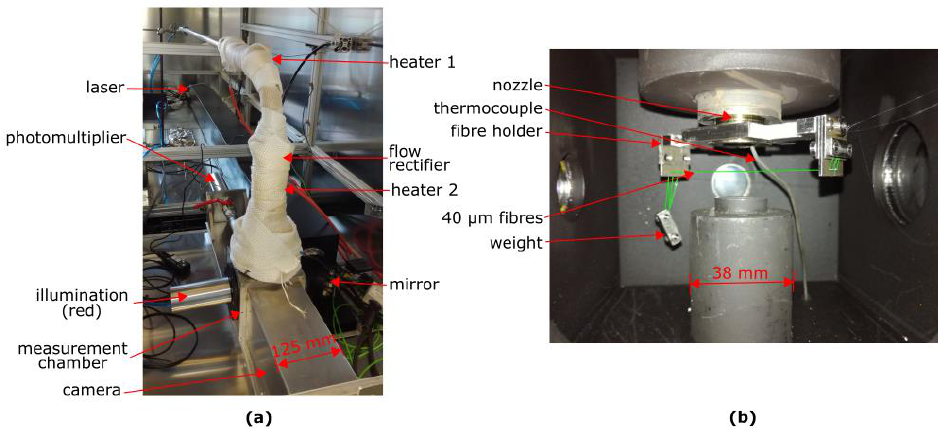
Figure 3. ( a ) Photograph of the novel apparatus; ( b ) Fibres mounted inside the measurement chamber. The fibres are marked with green lines in the right photograph.